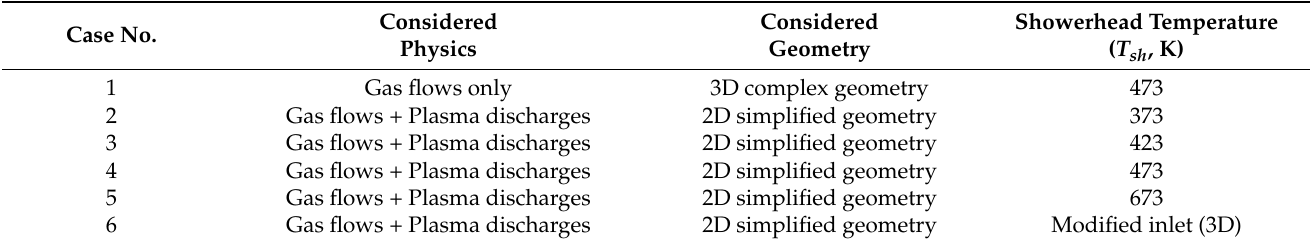
Table 1. List of cases considered in this study. Case 1 was considered in a three-dimensional geometry. Case